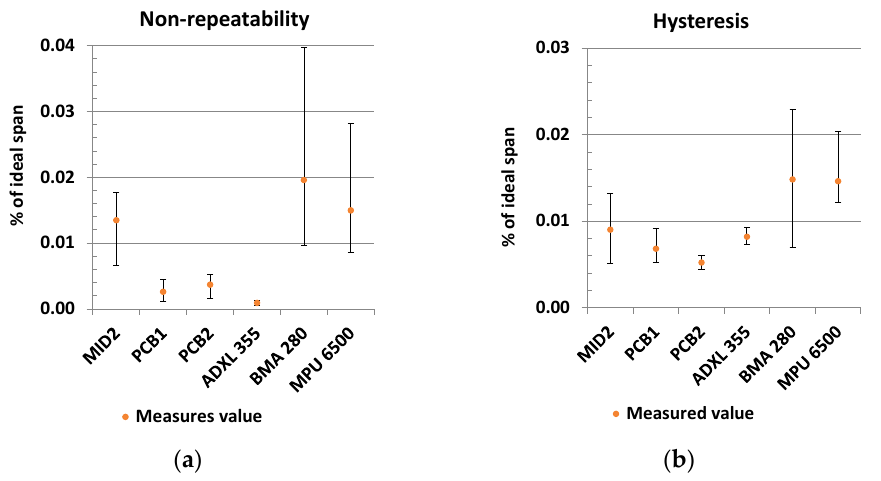
Figure 20. Characteristic curve: ( a ) Non-repeatability; ( b ) Hysteresis.